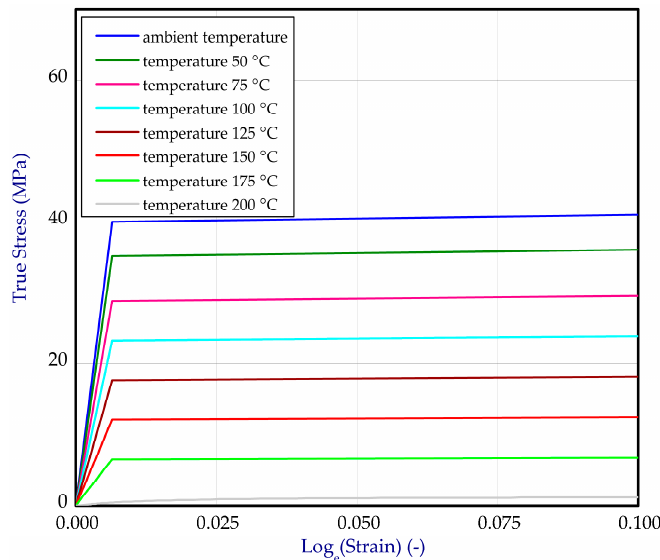
Figure 5. The tensile curves of true stress-logarithmic strain relation for adhesive.